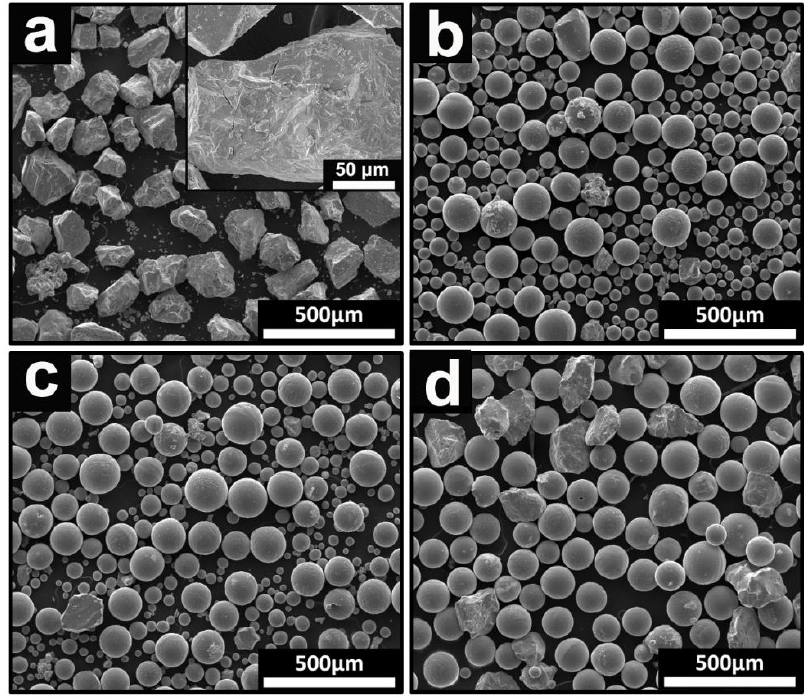
Figure 2. The micrograph show HDH titanium powder under different parameters: ( a ) without RF, ( b ) RF with a feeding rate of 30 g/min, ( c ) RF with a feeding rate of 45 g/min and ( d ) RF with a feeding rate of 60 g/min.